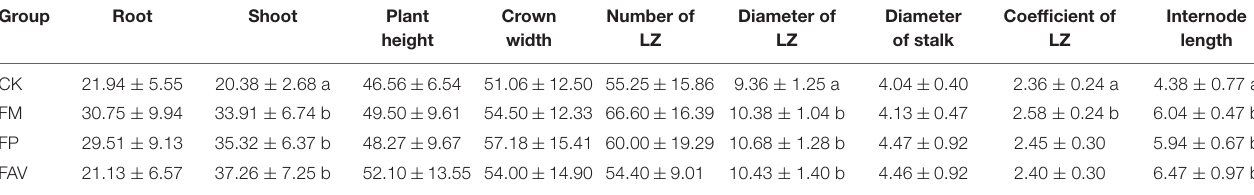
TABLE 2 | Growth indicators of L. chuanxiong for potted verification experiment. Group Root Shoot Plant